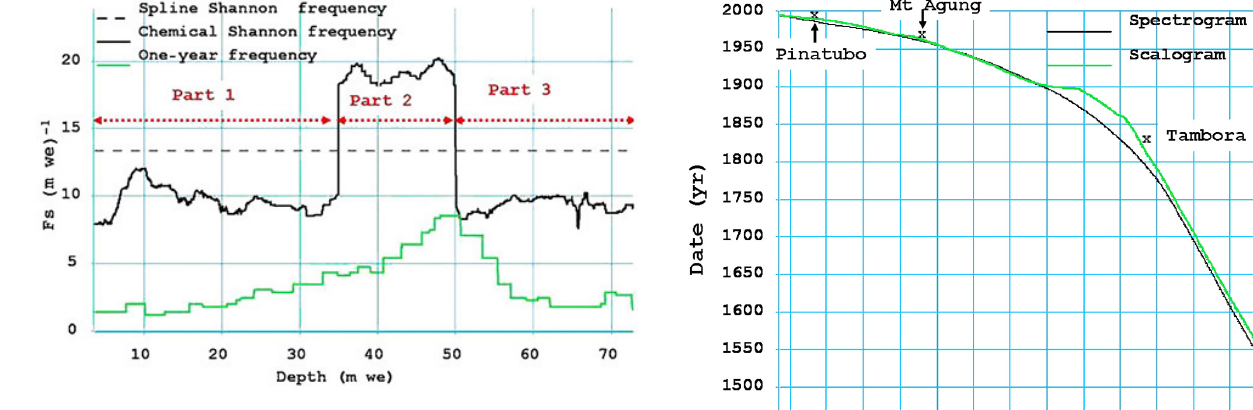
Figure 8. Nyquist–Shannon frequency deduced from the true core sampling (“Chemical Shannon frequency”, dark line); Nyquist– Shannon frequency deduced from the spline pre-processing (“Spline Shannon frequency”, dark dotted line); estimated spa- tial frequency provided by the spectrogram (“One-year frequency”, green line).